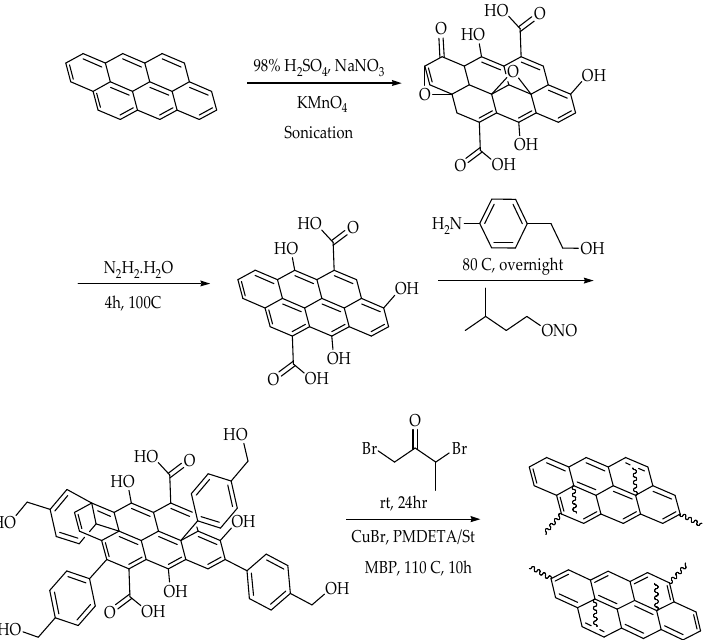
Figure 6. Schematic illustration of the fabrication of polystyrene-functionalised graphene nanosheets. H 2 SO 4 : sulphuric acid; NaNO 3 : sodium nitrate; KMnO 4 : potassium permanganate;